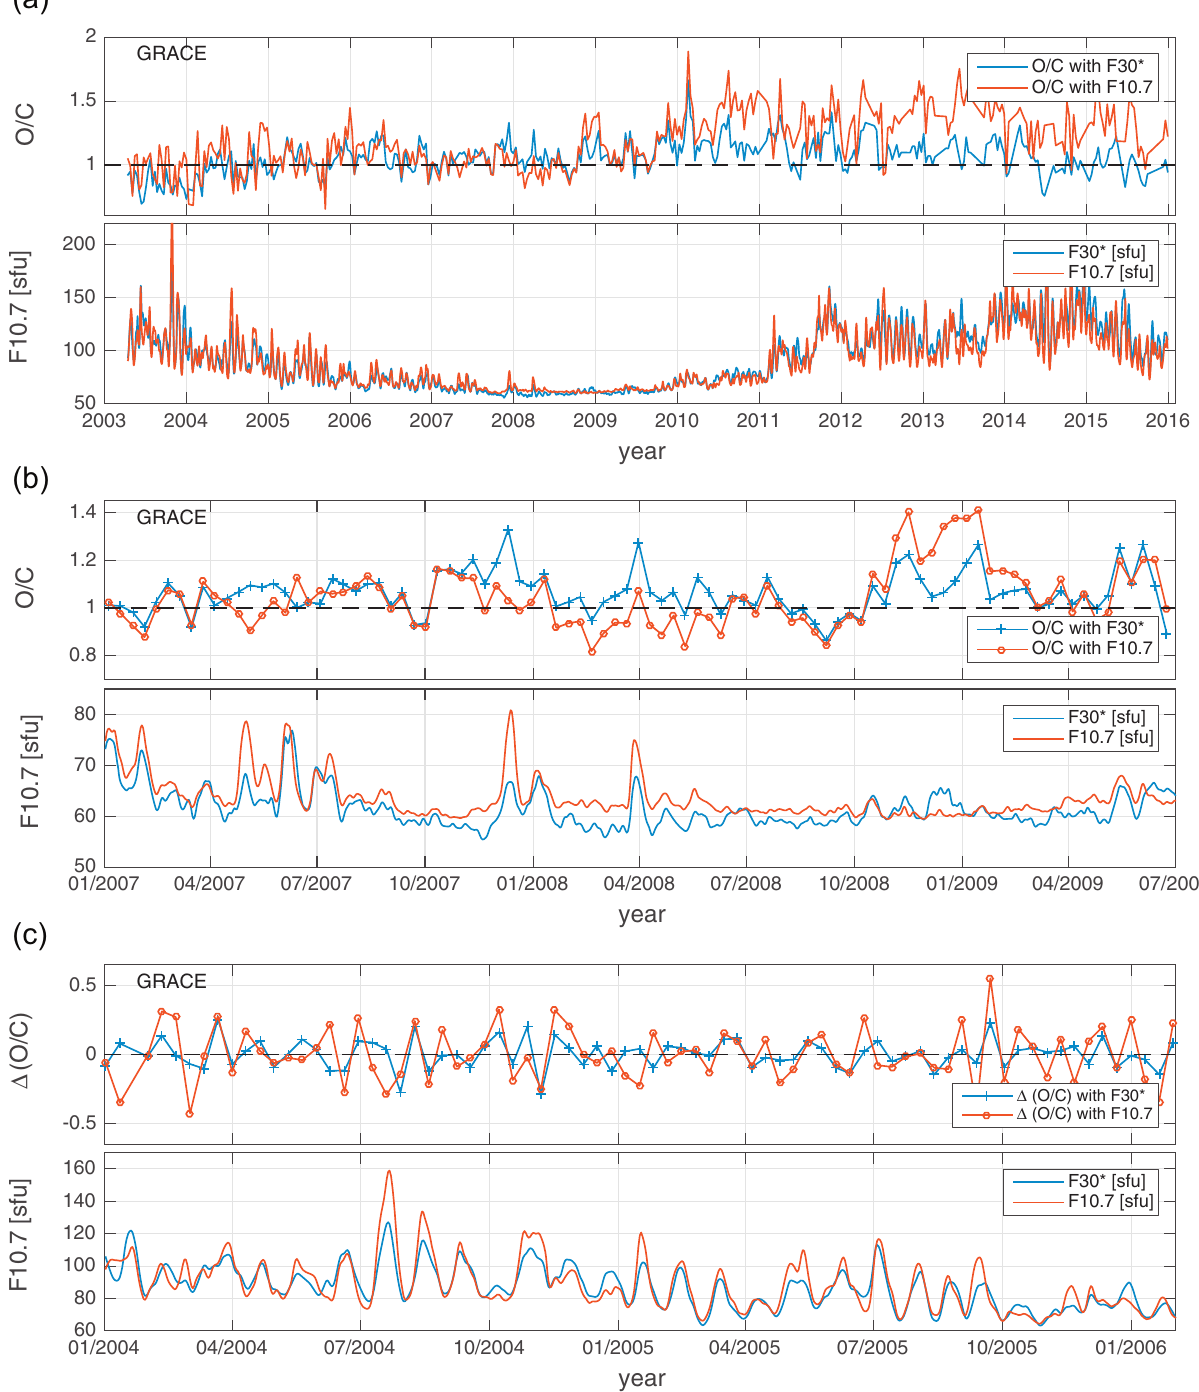
Fig. 8. 10-day averaged GRACE density ratios (O/C) obtained with the F10.7 and F30* thermosphere models and 81-day mean F10.7 and F30* proxies. (a) Full record, (b) zoom on the period January 2007–June 2009 and (c) the differenced density ratio D (O/C) (see Eq. 2) for the period January 2004–December